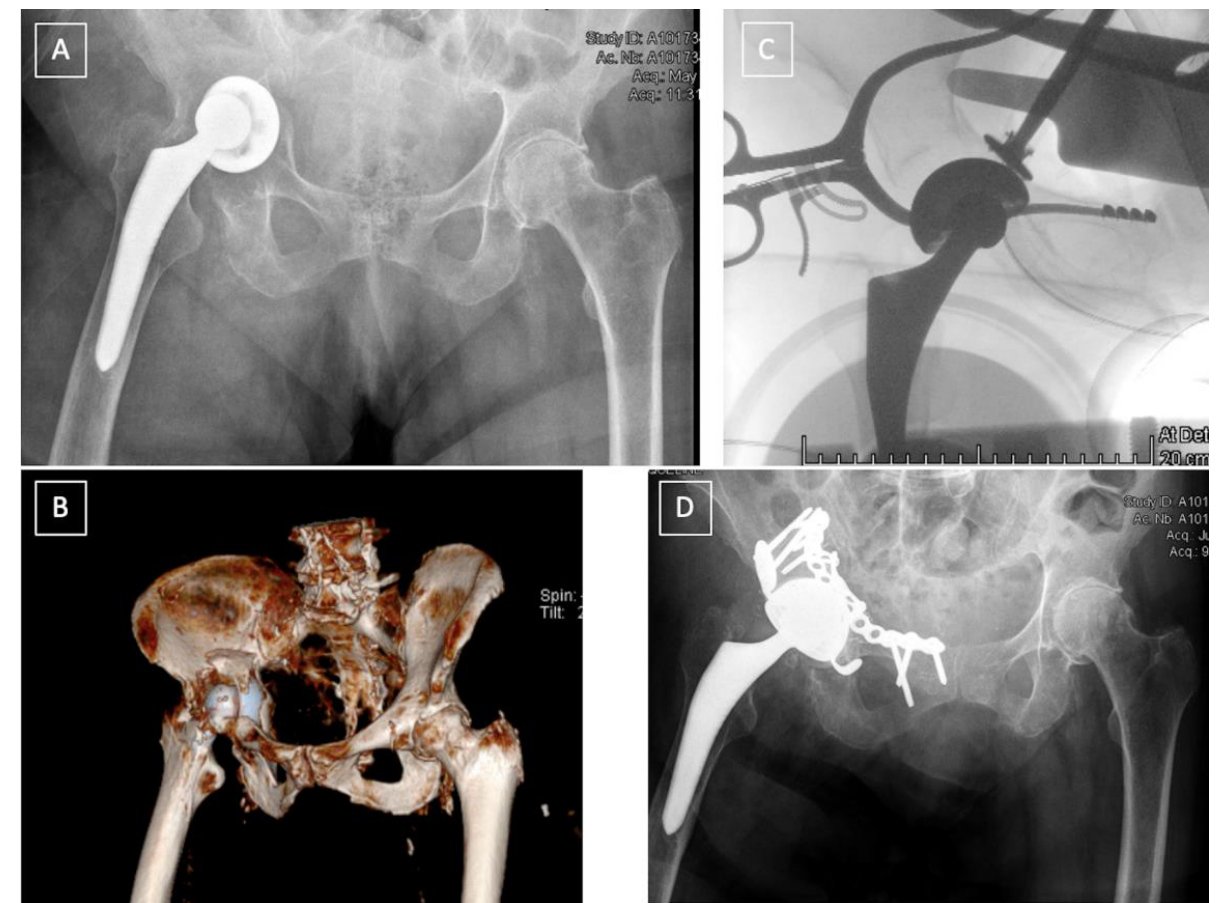
Figure 4. Acute post-operative fracture, following a low energy trauma, of the anterior column in a 94-year-old patient ( A , B ) treated by one stage surgery. Reduction and ORIF of the anterior column through a Stoppa approach, and revision of the cup through a direct anterior approach with reconstruction of the acetabulum and a cemented dual-mobility cup ( D ). Reduction of the cup can be achieved from the Stoppa approach ( C ).